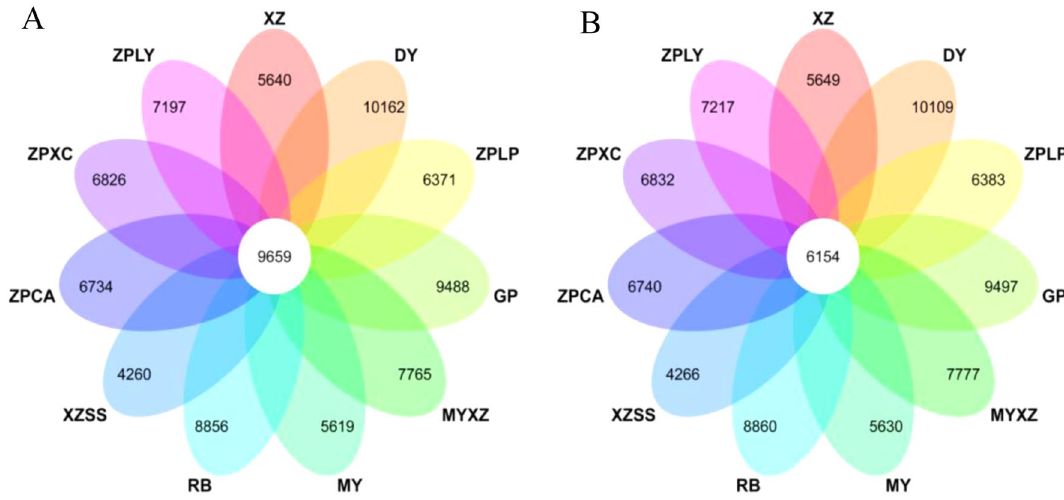
Figure 3. Venn diagrams for the selection of common genes and common single-copy genes among 10 germplasms of Chaenomeles and D. delavay . A shows the selection of common genes in the 11 materials, B shows the selection of common single-copy genes in the 11 materials. Only common genes among the 11 materials and specific genes in each germplasm are shown in this graph. The diagrams were visualized on https:// www. omics hare. com/ tools/.